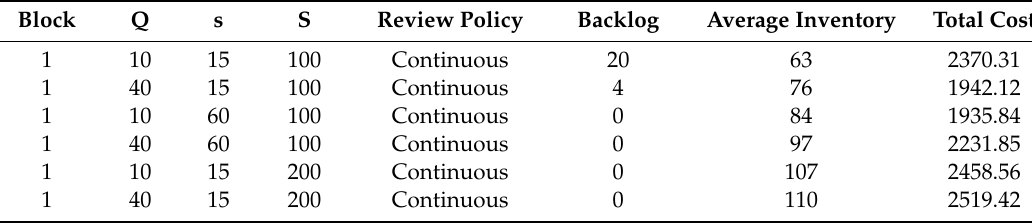
Table A2. Data set for running full factorial design with 21